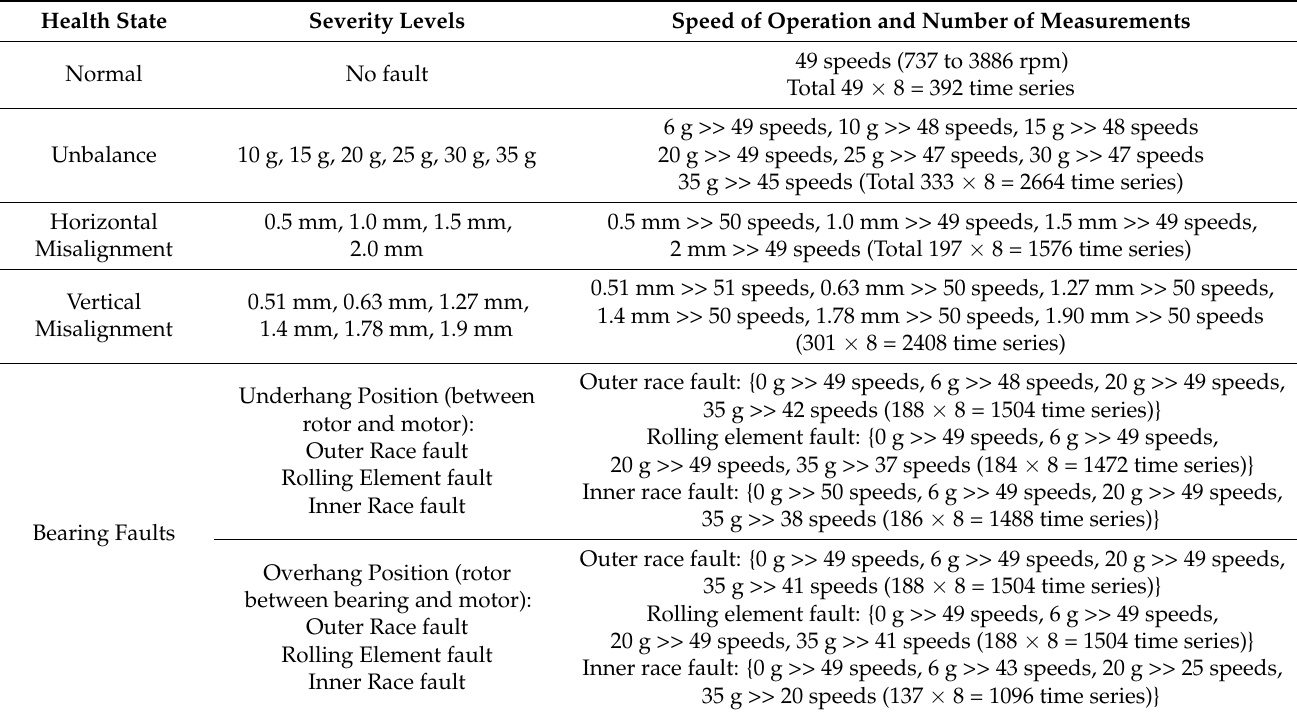
Table 1. Summary of different health